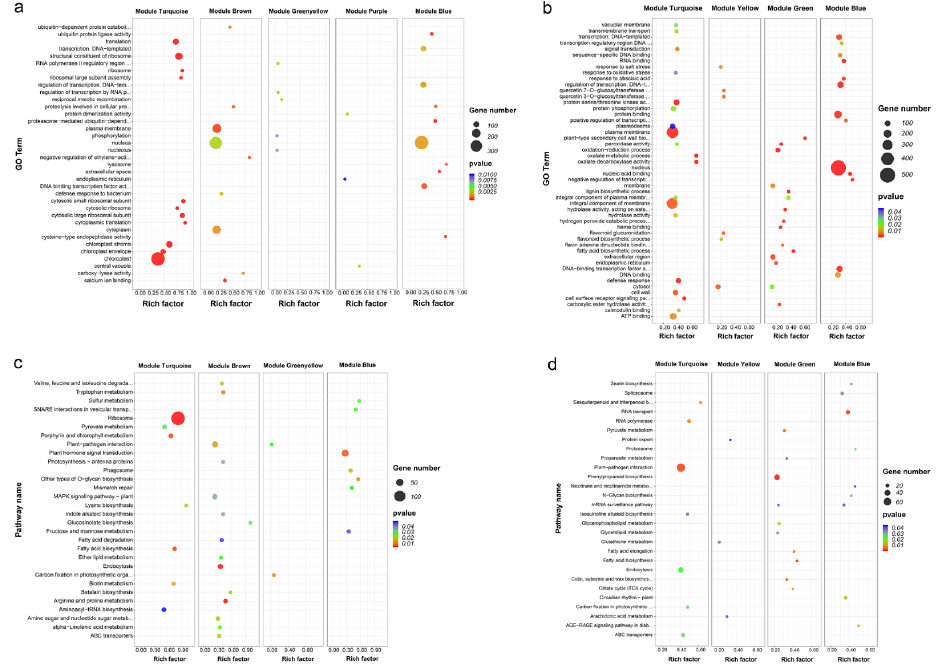
Figure 5. Functional enrichment analysis for genes in each critical module . GO enrichment for critical modules in leaves ( a ) and roots ( b ); KEGG enrichment for critical modules in leaves ( c ) and roots ( d ). KEGG enrichment analysis demonstrated that DEGs in leaf module turquoise were substantial enriched in ribosome (ko03010), fatty acid biosynthesis (ko00061), porphyrin and chlorophyll metabolism (ko00860), biotin metabolism (ko00780), and lysine biosyn- thesis (ko00300) pathway. DEGs in leaf module brown were substantially enriched